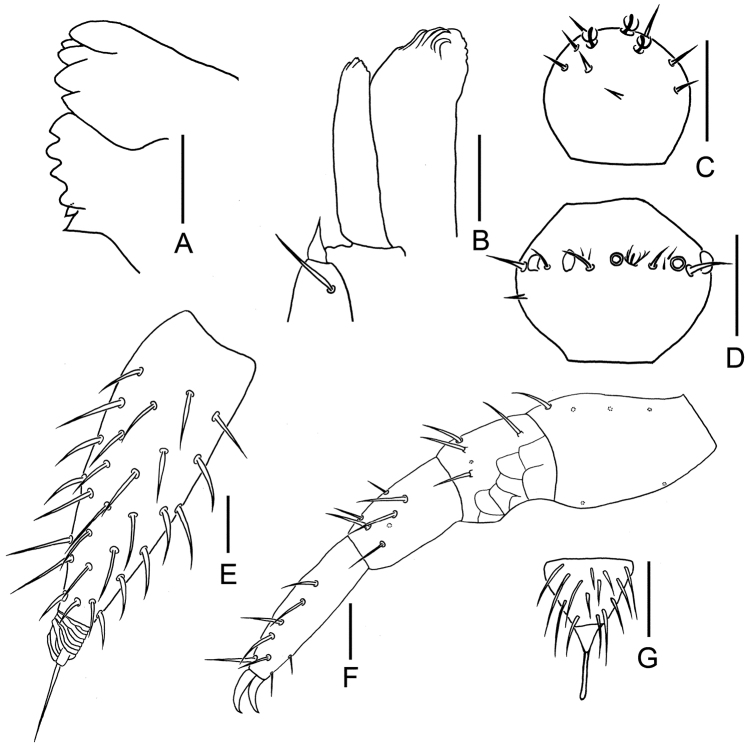
Symphylella
communa sp. nov. A mandible B first maxilla C left apical antennomere, dorsal view D left 13th antennomere, dorsal view E left cercus, dorsal view F 12th leg G stylus on base of 3rd leg, right side. Scale bars: 20 μm (A–F); 5 μm (G).